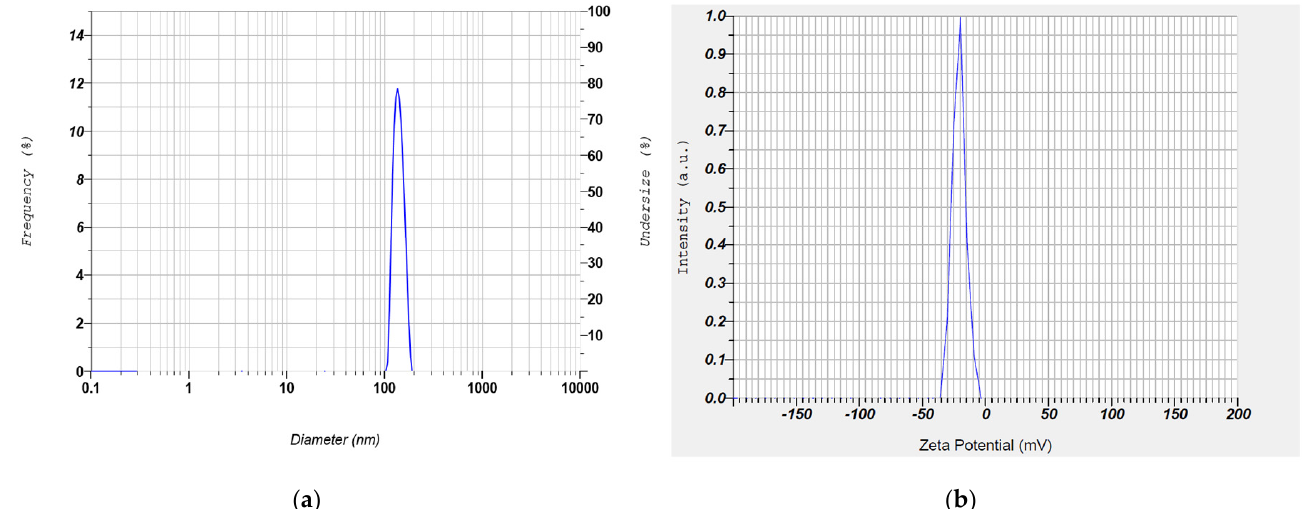
Figure 10. Representative size distribution curve ( a ) and zeta potential distribution ( b ) of optimized clarithromycin solid lipid nanoparticle (CL10).